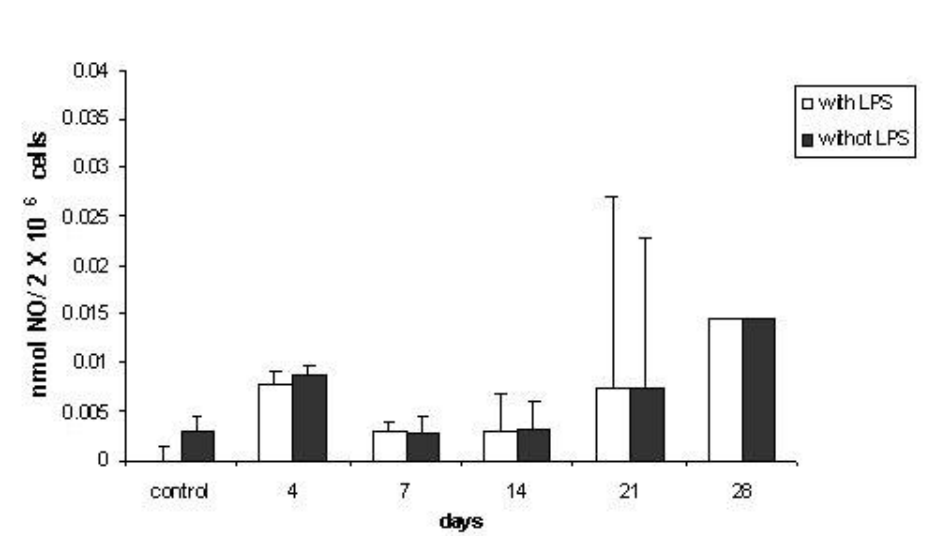
Figure 3. Mean NO concentrations (±SD) in the culture supernatant with or without LPS stimulation for 24 hours in hamsters inoculated with L. interrogans Icterohaemorrhagiae and their respective control group.